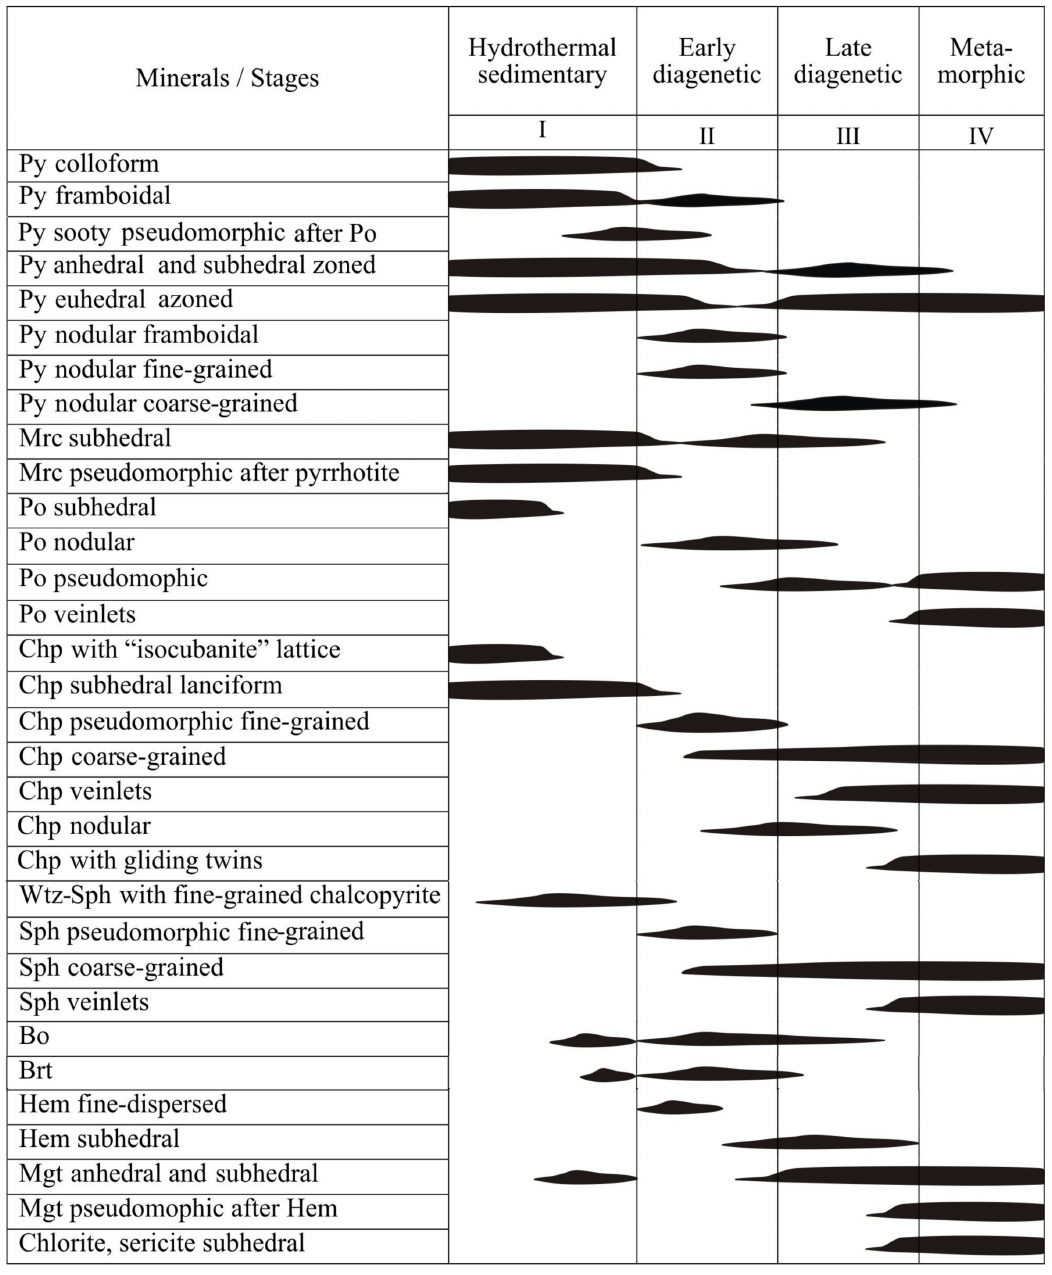
Figure 20. Simplified succession of major minerals of ore diagenites of the Urals VHMS